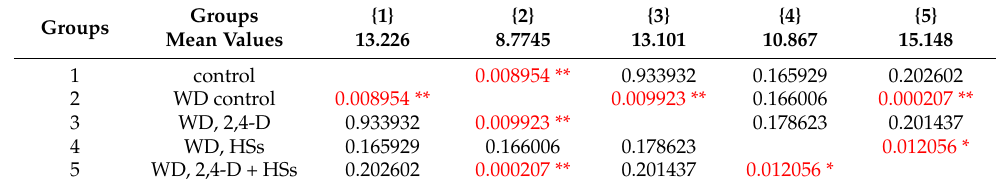
Figure 3. Concentration of chlorophyll (Chl) in leaves of wheat plants 7 days after treatment with Pseudomonas plecoglossicida 2,4-D (2,4-D), humic substances (HSs) and their combinations (2,4-D + HSs) under well-watering (WW) and in water deficit (WD) conditions. Statistically different means are marked with different letters, p ≤ 0.05, n = 30 (ANOVA followed by Duncan’s test). Table 5. ANOVA test for chlorophyll content followed by Duncan test. Values in the cells correspond to p for the difference between the mean values; p ≤ 0.05 is marked with *; p ≤ 0.01—with ** for control plants untreated with either bacteria or HSs and plants grown under water deficit (WD): con- trol, plants treated with Pseudomonas plecoglossicida 2,4-D (2,4-D), humic substances (HSs) and their combinations (2,4-D +